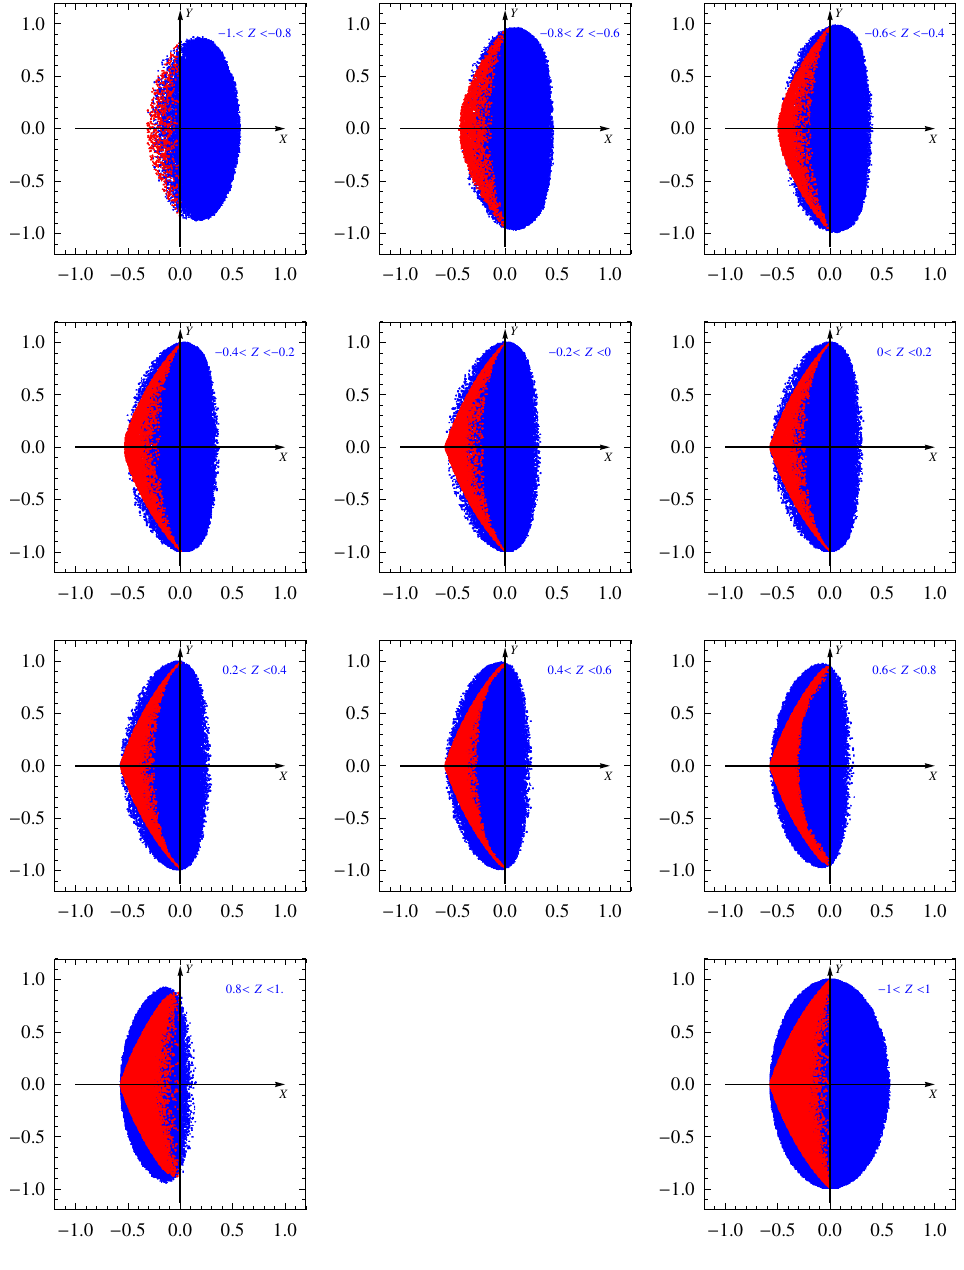
Figure 3 . Dirac and Majorana bounds on ( X; Y; Z ) in non-relativistic scattering. For di(cid:11)erent values of Z , allowed regions are shown with blue (Dirac) and red (Majorana) points. The last plot (right bottom) shows the combination of all possible values of Z , which reproduces the result from (cid:12)gure 2.